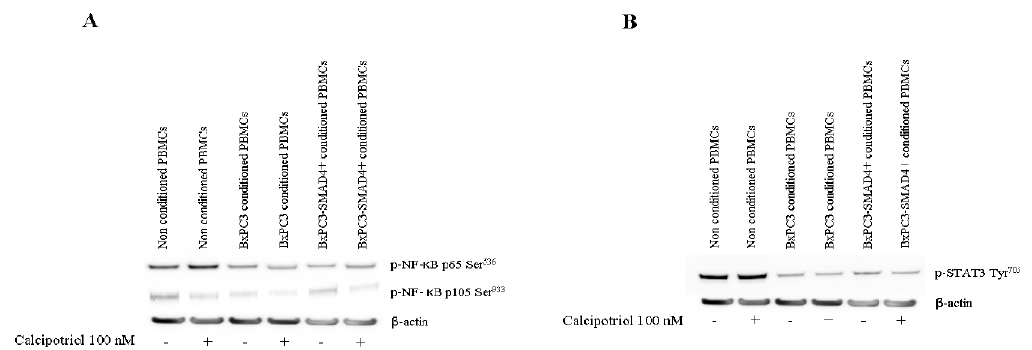
Figure 5. Western blot analyses obtained from PBMCs cultured or not cultured with BxPC3 or BxPC3- SMAD4 + conditioned media in the presence or in the absence of 100 nM calcipotriol. Representative targets of the NF- κ B (panel A ) and STAT-3 (panel B ) pathways are shown.